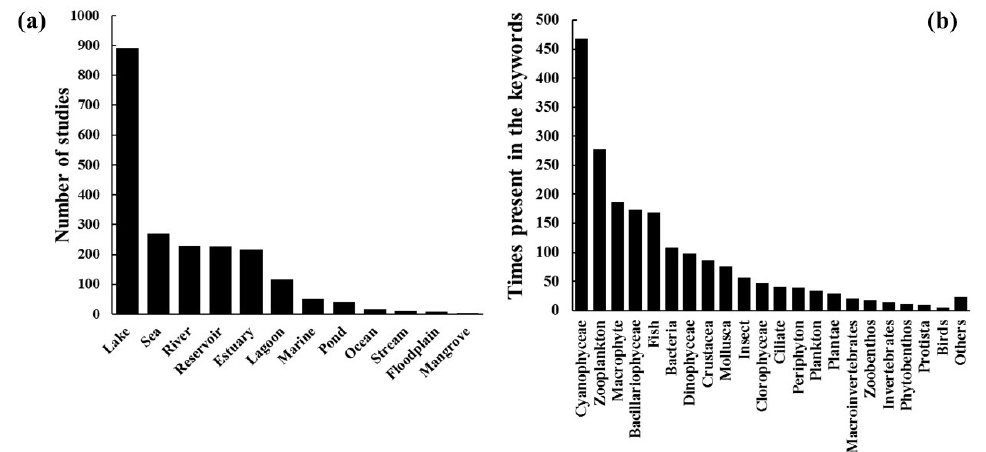
Figure 6. Multiple regression of the publication number using HDI and total area as predictors. r 2 p =0,000008. The countries are separate by the economic status DC= developed country, DIC= developing countries, LDC= less developed country, LLDC= least developed country.